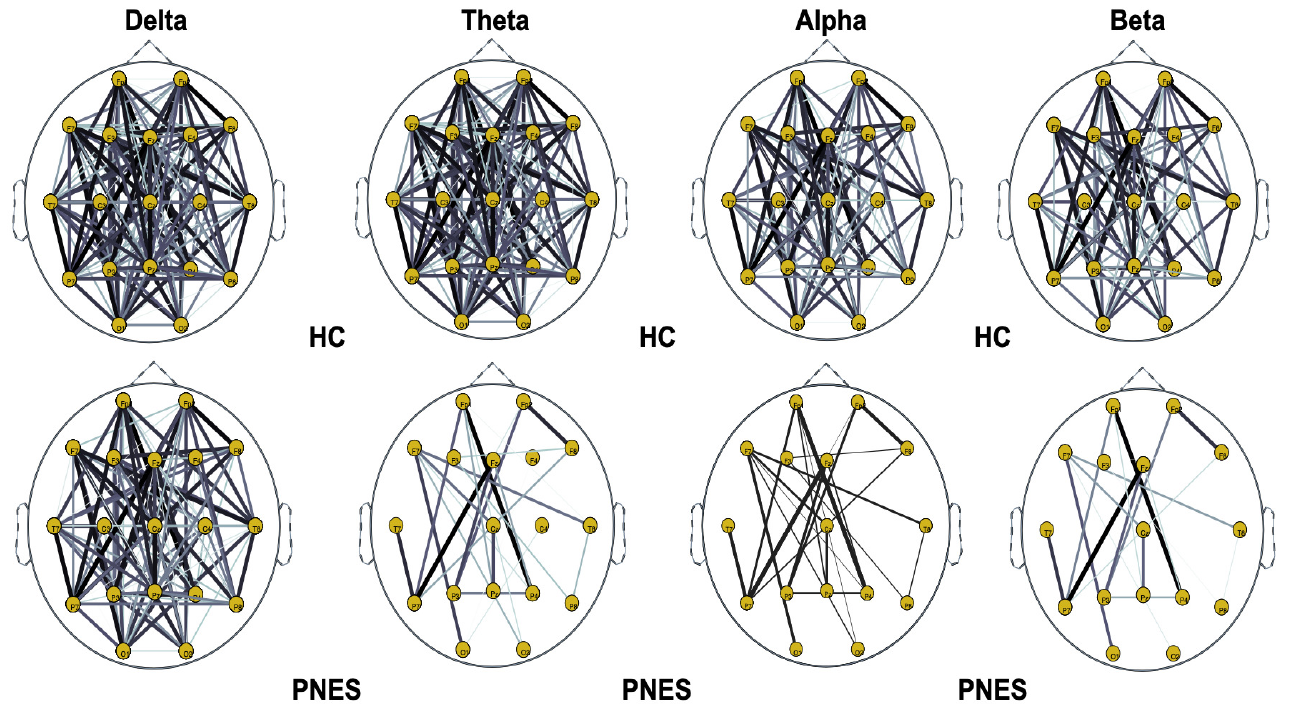
Figure 5. Distribution of PLI for th = 0.05 level of the connection strength, in healthy subjects and PNES in delta, theta, alpha, and beta frequency bands. The line thickness highlights path with high value of PLI.